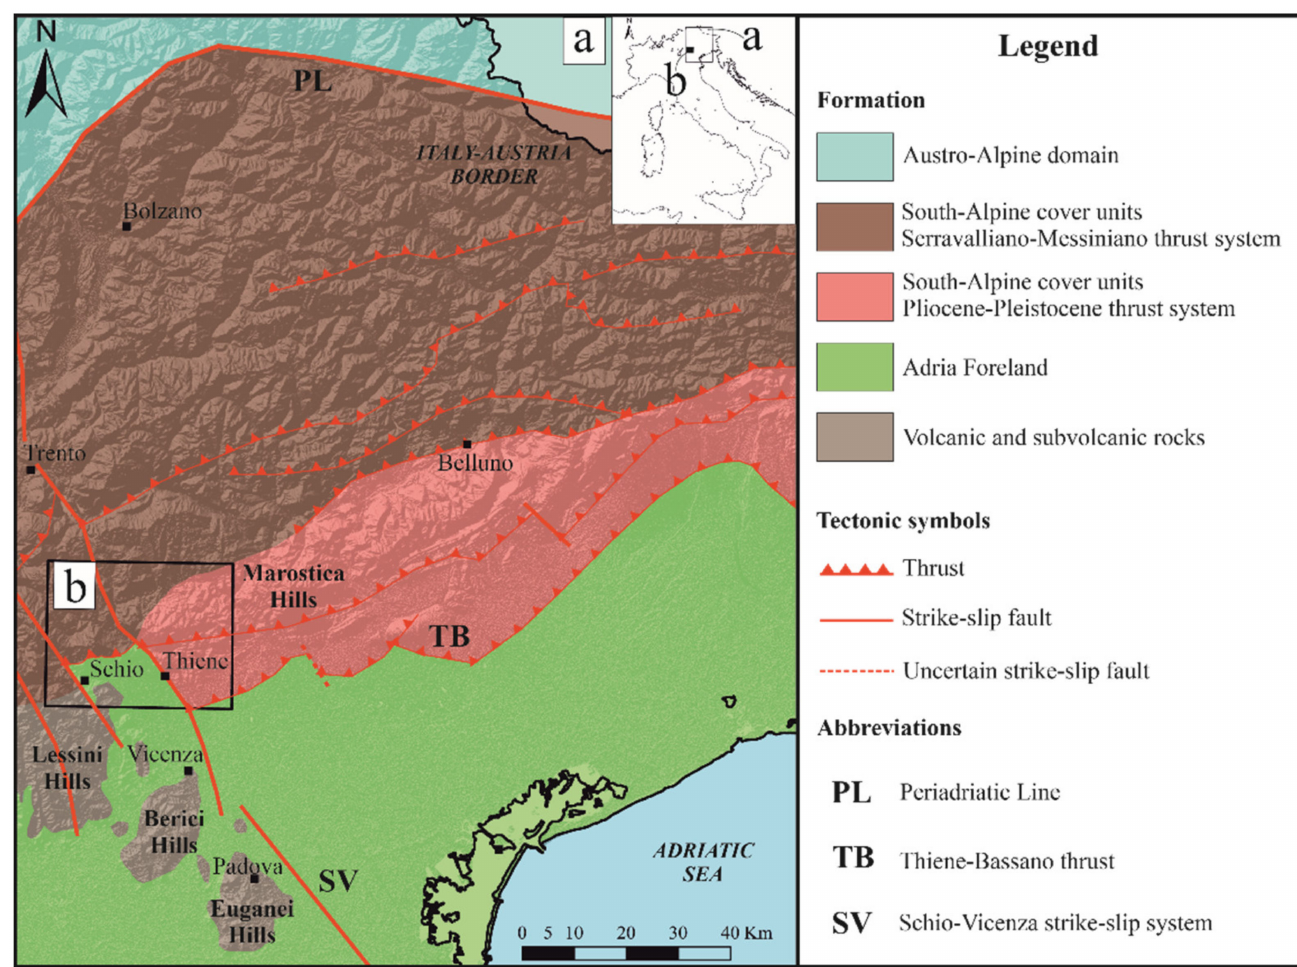
Figure 1. ( a ) Structural model of the Veneto area [13–15]; ( b ) study area corresponding to Figure 2. Sub-volcanic dykes and diatremes at Tonezza del Cimone and Castelletto di Rotzo have an Oligocene age [16]. The entire area hosts dozens of dissected, en-echelon dykes varying from a meter to 10 m thick. Castelletto di Rotzo outcrop consists of a dyke-diatreme system, hosted in Barremian limestones (Majolica or Biancone) and maybe in Hettangian- Domerian limestones (Calcari Grigi group) and partially covered by fluvioglacial-morainic deposits (Figure 2) [17]. Tonezza del Cimone are poorly studied and deserve more attention and a future petrological study. Interestingly, one of the authors (FS) has discovered carbonatitic diatremes in Tonezza del Cimone, ultramafic rocks with CaO >30 wt% and CO 2 >20 wt % have recently been discovered (F. Stoppa personal communication). Mantle- xenoliths are frequent and testify to a rapid rise of the magma from the mantle towards the